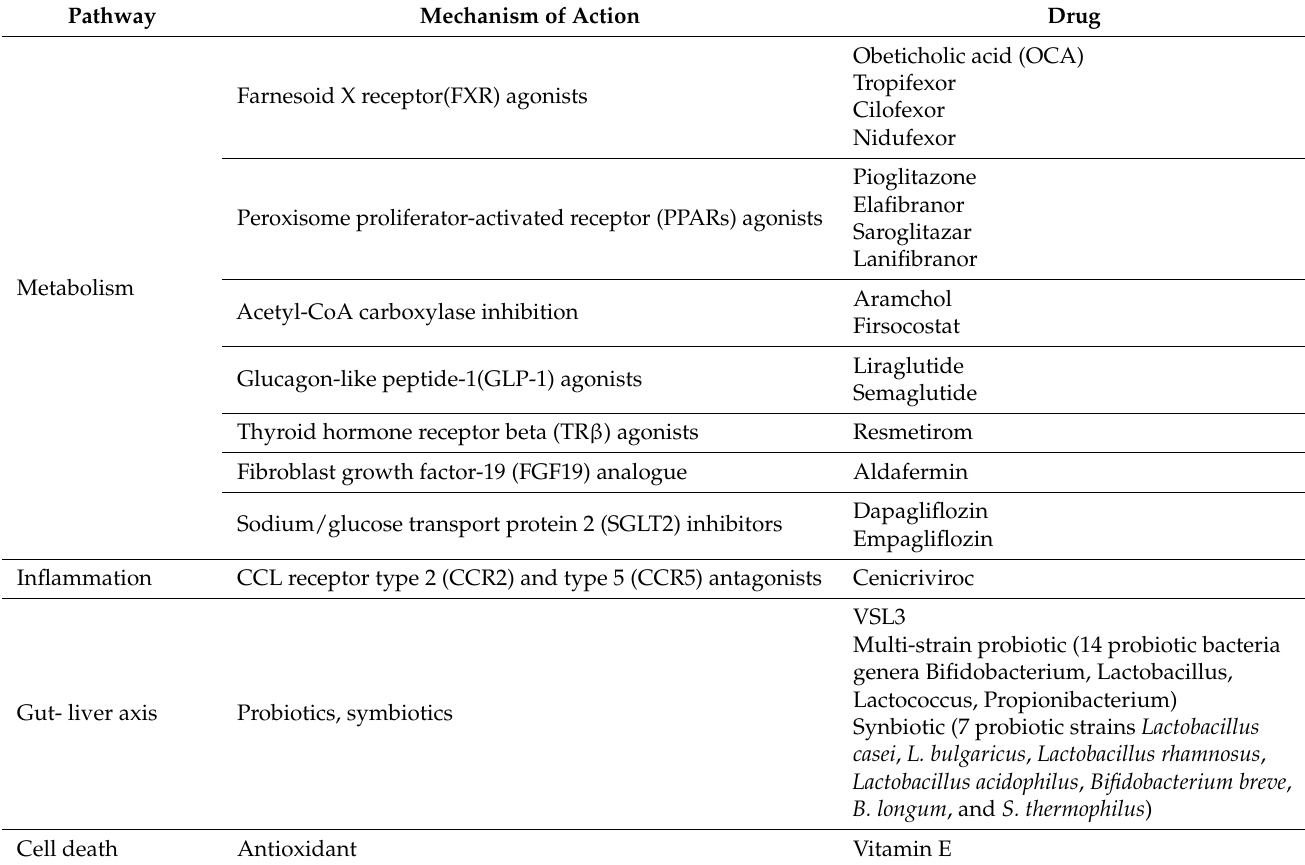
Table 1. Innovative therapeutic strategies in